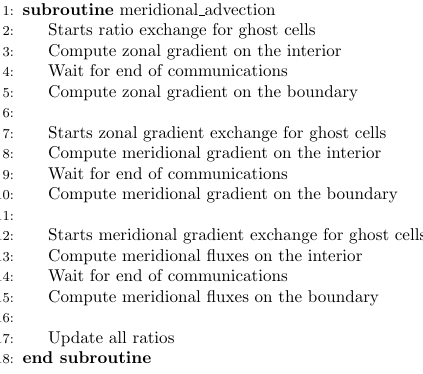
Figure 17. Main steps of the algorithm for zonal (left) and meridional (right) advection.